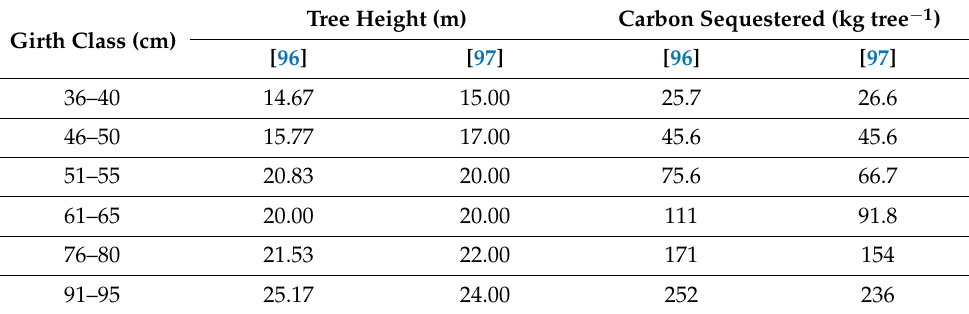
Table 8. Girth class-wise comparisons of growth and carbon sequestration in eucalyptus trees were recorded by [97,98] in